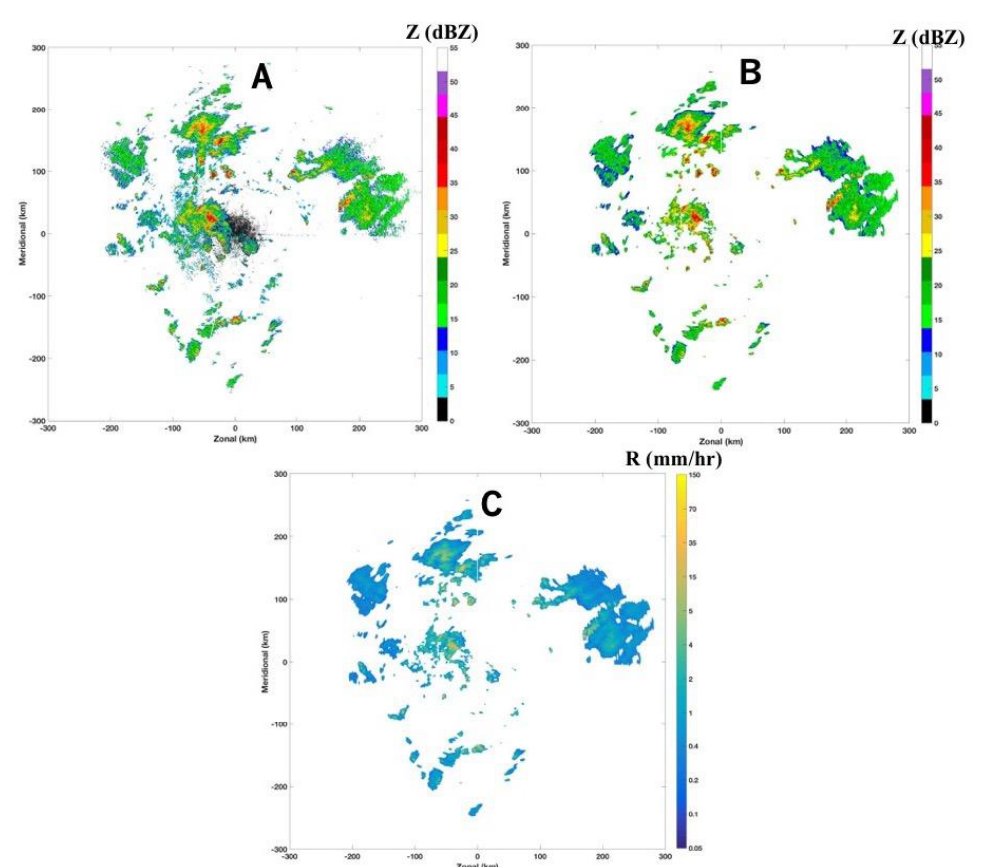
Figure 2. The reflectivity fields from ( A ) before and ( B ) after the quality control process and ( C ) the estimated rainfall rate using polarimetric radar variables.